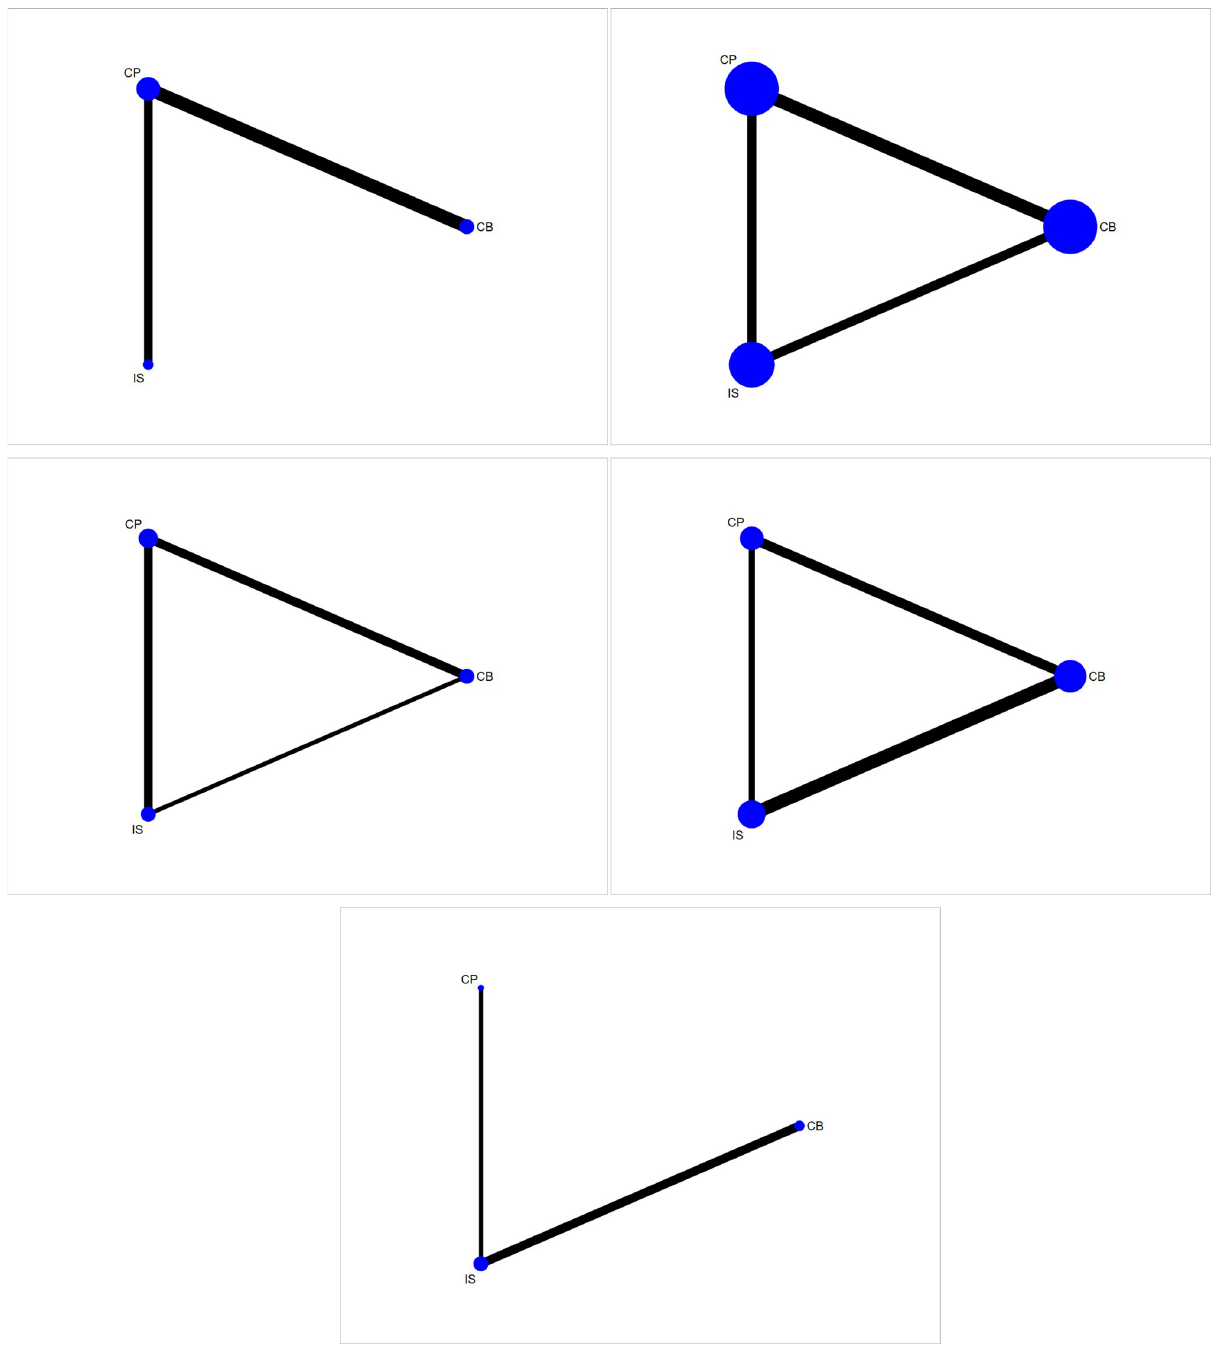
Fig 3. Network plots of fixation method comparisons for various outcomes. 3A: KT-1000 assessment; 3B: IKDC score A or B; 3C: Lachman’s test; 3D: Pivot-shift test; 3E: VAS score. IKDC: International Knee Documentation Committee; VAS: visual analogue scale; CB: cortical button; CP: cross- pin; IS: interference